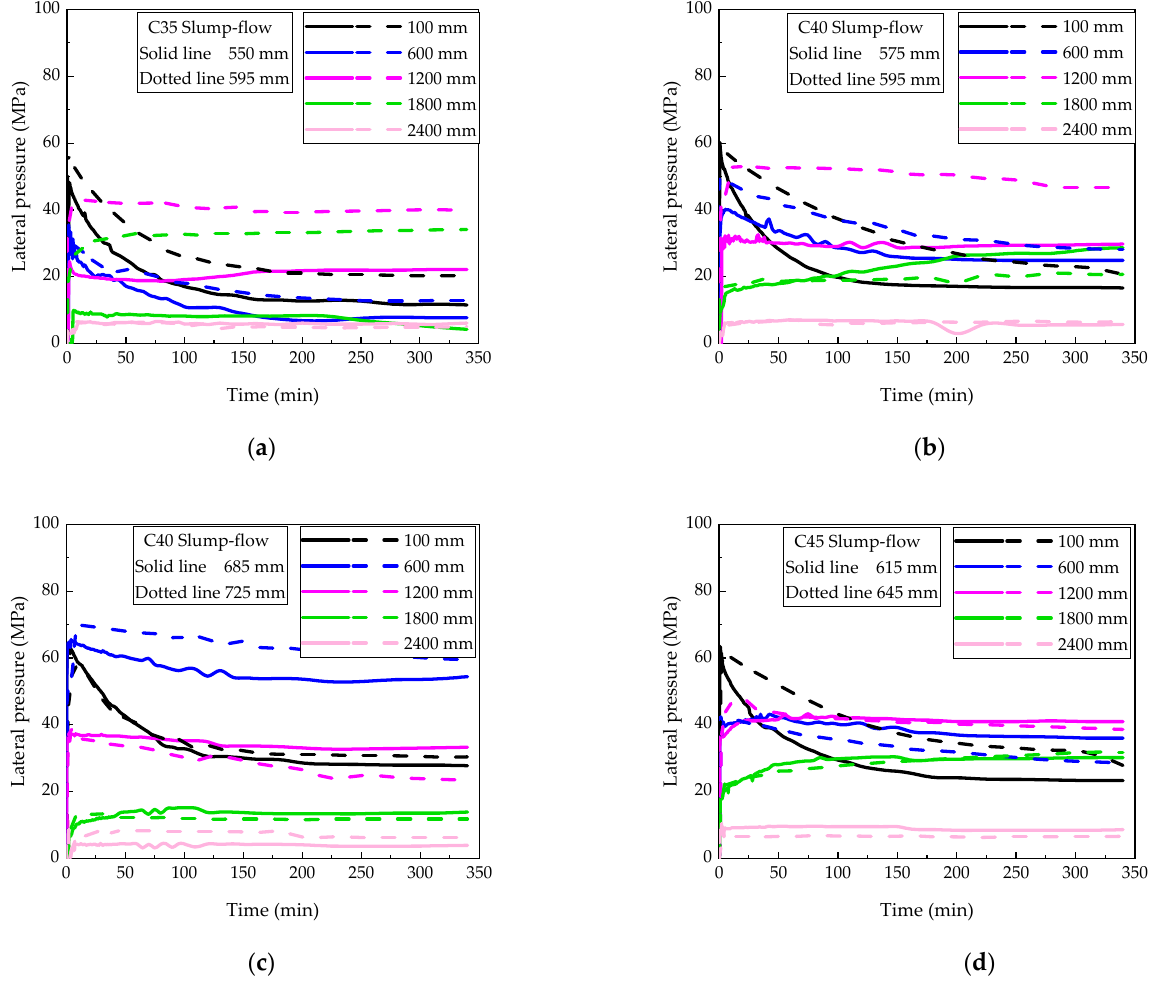
Figure 2. Lateral pressure on formwork at different heights over time: ( a ) C35 with slump-flow of 550 mm and 595 mm; ( b ) C40 with slump-flow of 575 mm and 595 mm; ( c ) C40 with slump-flow of 685 mm and 725 mm; ( d ) C45 with slump-flow of 615 mm and 645 mm. With the increase in time after casting, the peak lateral pressure decreased while the lateral pressure at the heights of 1200 mm, 1800 mm, and 2400 mm changed little after the time exceeded 100 min. This was due to the decrease in flowability of fresh SCC with